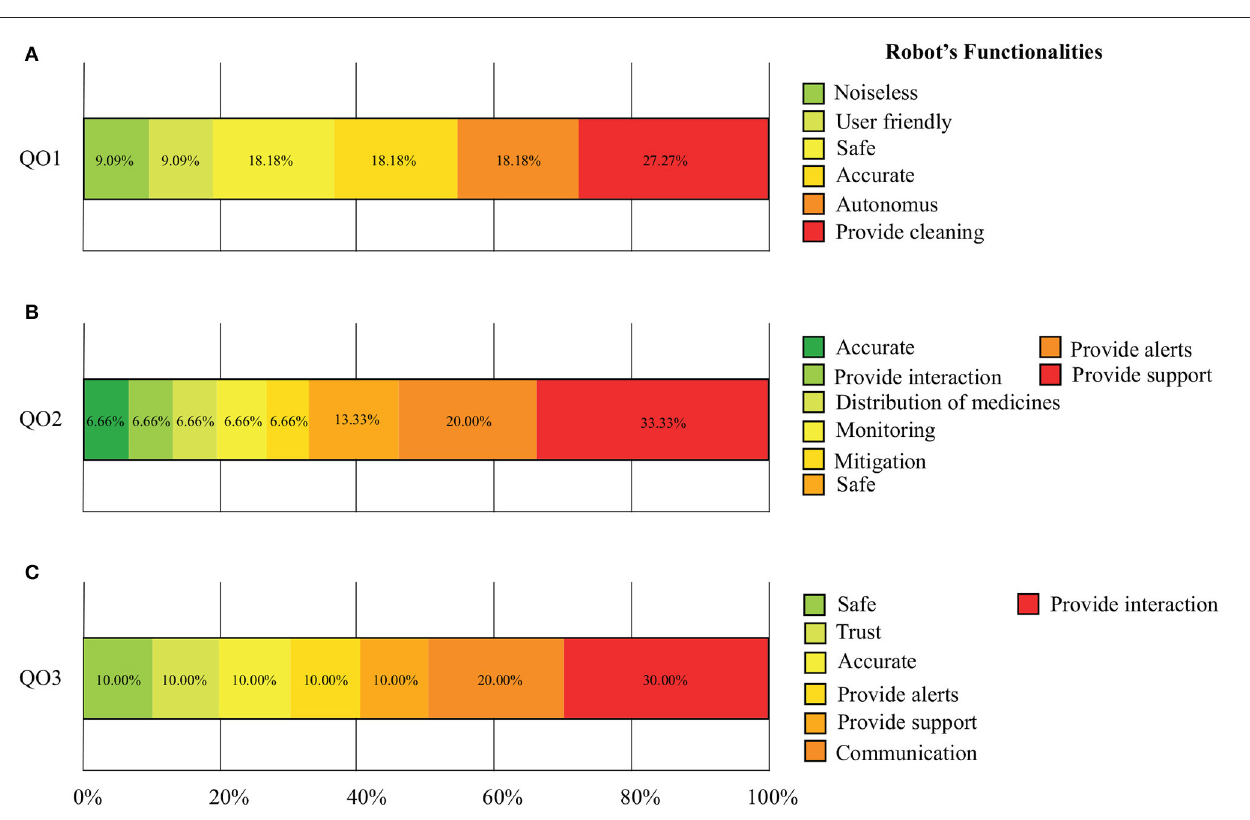
FIGURE 3 | Results of the perception questions toward the scope of Robotics for COVID-19 in Colombia. QCOL1 assess the perception of the potential to develop robotic solutions in Colombia. QCOL2 assess the perception of barriers to implement robotic solutions. QCOL3 assess the need for robotic solutions for disinfection, assistance and telemedicine during COVID-19 pandemic.